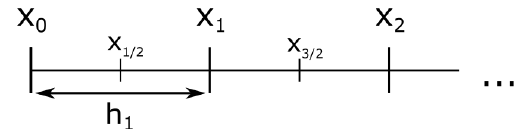
Figure 2. Illustration of the grid